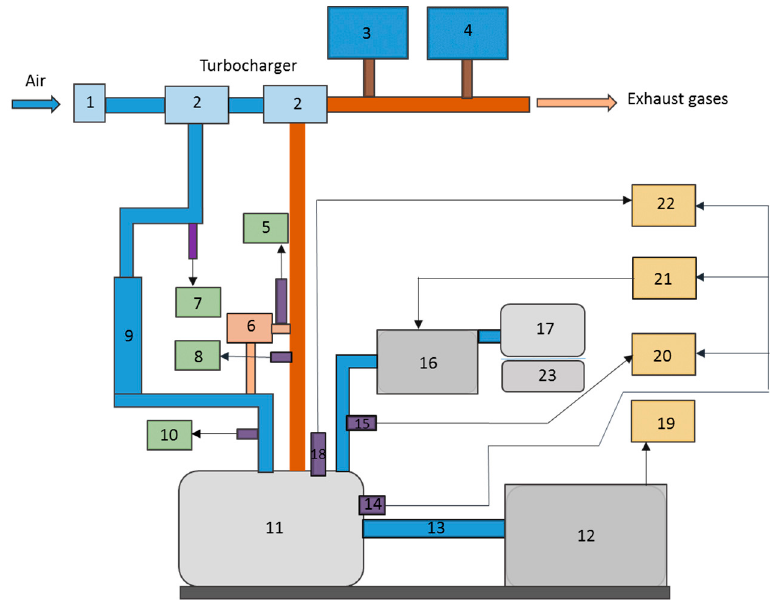
Figure 1. Schematic of engine testing equipment: 1–Air mass meter; 2–Turbocharger; 3–Gas analyser; 4–Smoke analyser; 5–Temperature sensor; 6–EGR valve; 7–Air pressure meter; 8–Exhaust gas temperature meter; 9–Air cooler; 10–Intake gas temperature meter; 11–1.9 TDI engine; 12–